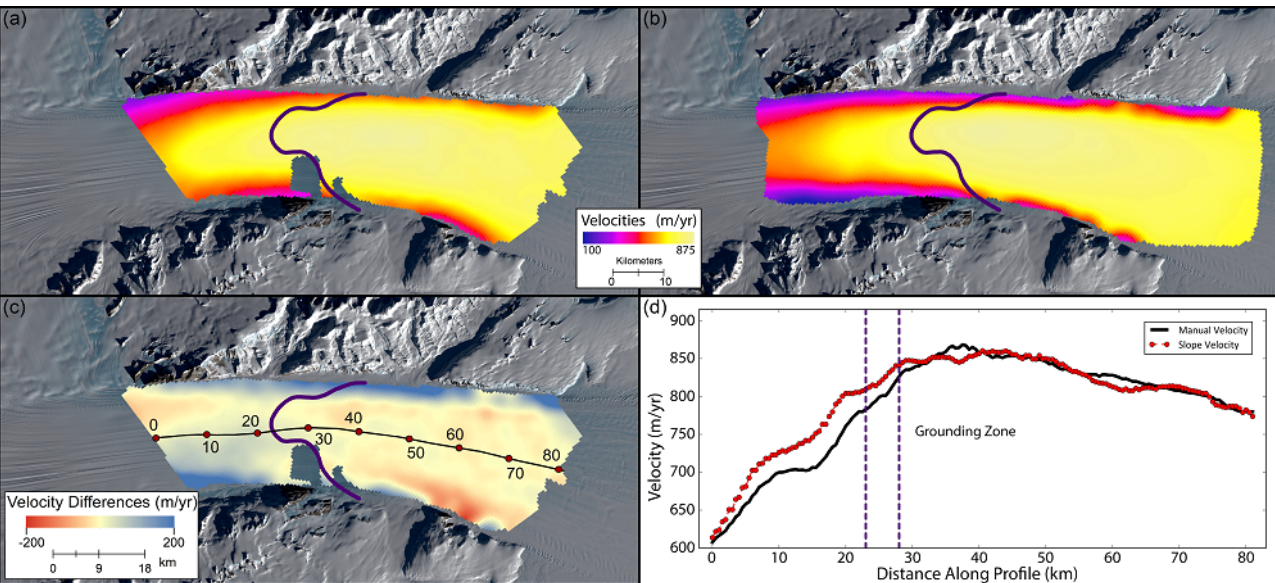
Figure 10. ( a ) Velocities from elevation slopes. The missing section in the middle of the grid is due to poor correlations that left a gap too large to interpolate accurate magnitudes. ( b ) Brecher’s [14] gridded velocities from contours. ( c ) Difference map of the two velocities. The line and labeled points represent the profile plot in ( d ). The points represent points along the profile in kilometers. ( d ) Velocity profiles of both velocities with the grounding zone highlighted in the dashed vertical